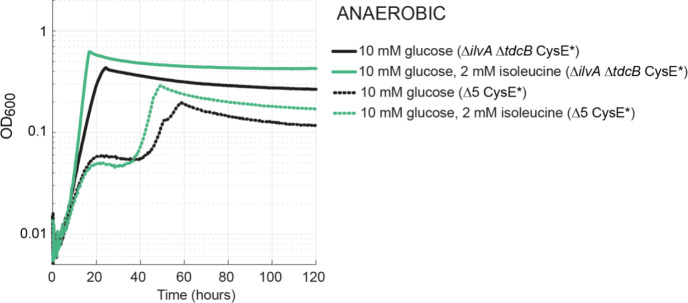
Growth via the MetB-dependent pathway under anaerobic conditions.Both the isolated ΔilvA ΔtdcB CysE* (solid line) and MAGE-generated Δ5 CysE* (dotted line) strains grew under anaerobic conditions without the medium addition of isoleucine (or propionate). The biphasic growth of the engineered Δ5 CysE* strain is unusual, but we note the same growth is observed for the positive control (green dotted). The timeframe of this growth and the lack of propionate in the media rule out PFL-dependent growth.